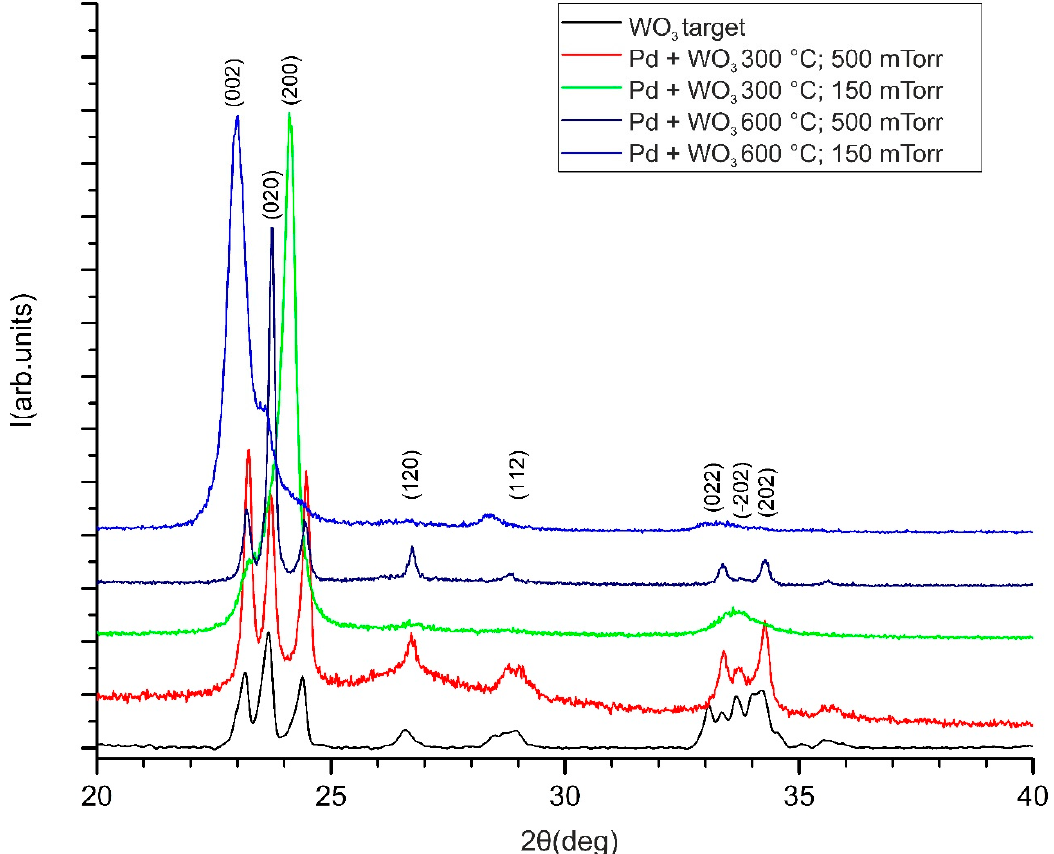
Figure 5. XRD patterns of the WO 3 target and the Pd/WO 3 sensitive films deposited in various temperature and pressure conditions. Table 1. Structural information of the Pd/WO 3 sensing films deposited in various conditions. The standard sample is WO 3 powder, ICCD card No.043-1035. The WO 3 target is a pressed pellet. The deposition conditions for the films are: S1 300 ◦ C/500 mTorr O 2 , S2 300 ◦ C/ 150 mTorr O 2